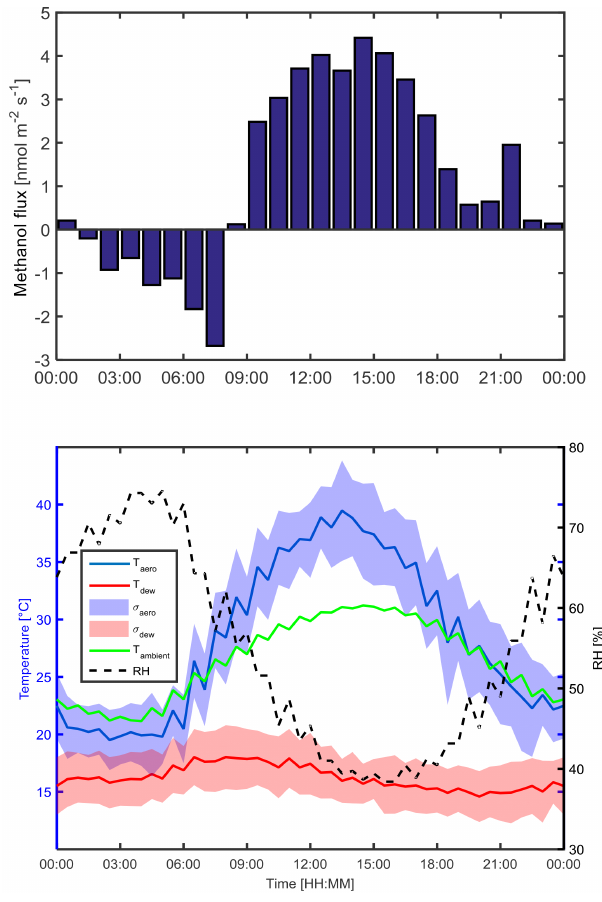
Figure 10. Diurnal exchange of the methanol (top panel) and the calculated aerodynamical ( T aero ) , dew point ( T dew ) and ambient temperature ( T ambient ; bottom panel). The blue and red shaded ar- eas indicate the standard deviation of the calculated temperatures and the dashed line is the relative